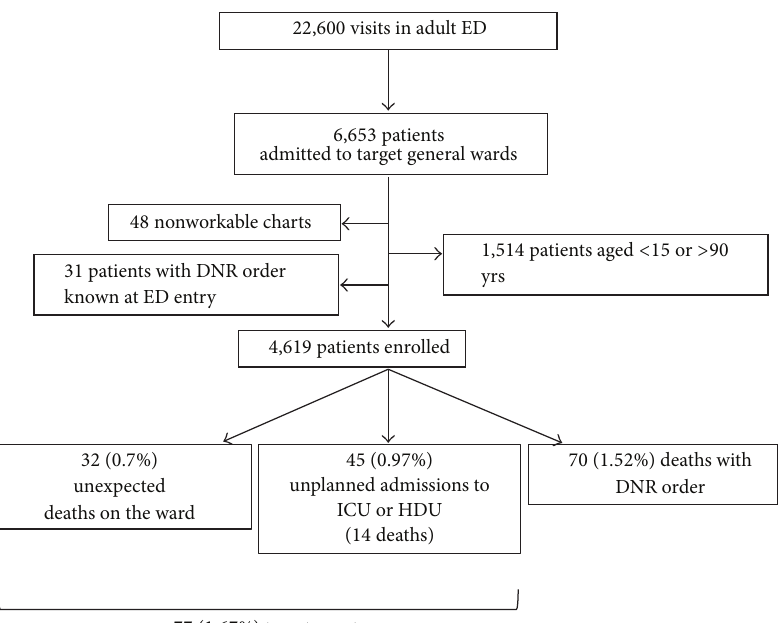
Figure 1: Flow diagram. ICU: intensive care unit; HDU: high dependency units; ED: emergency department; DNR order: do-not-resuscitate order.